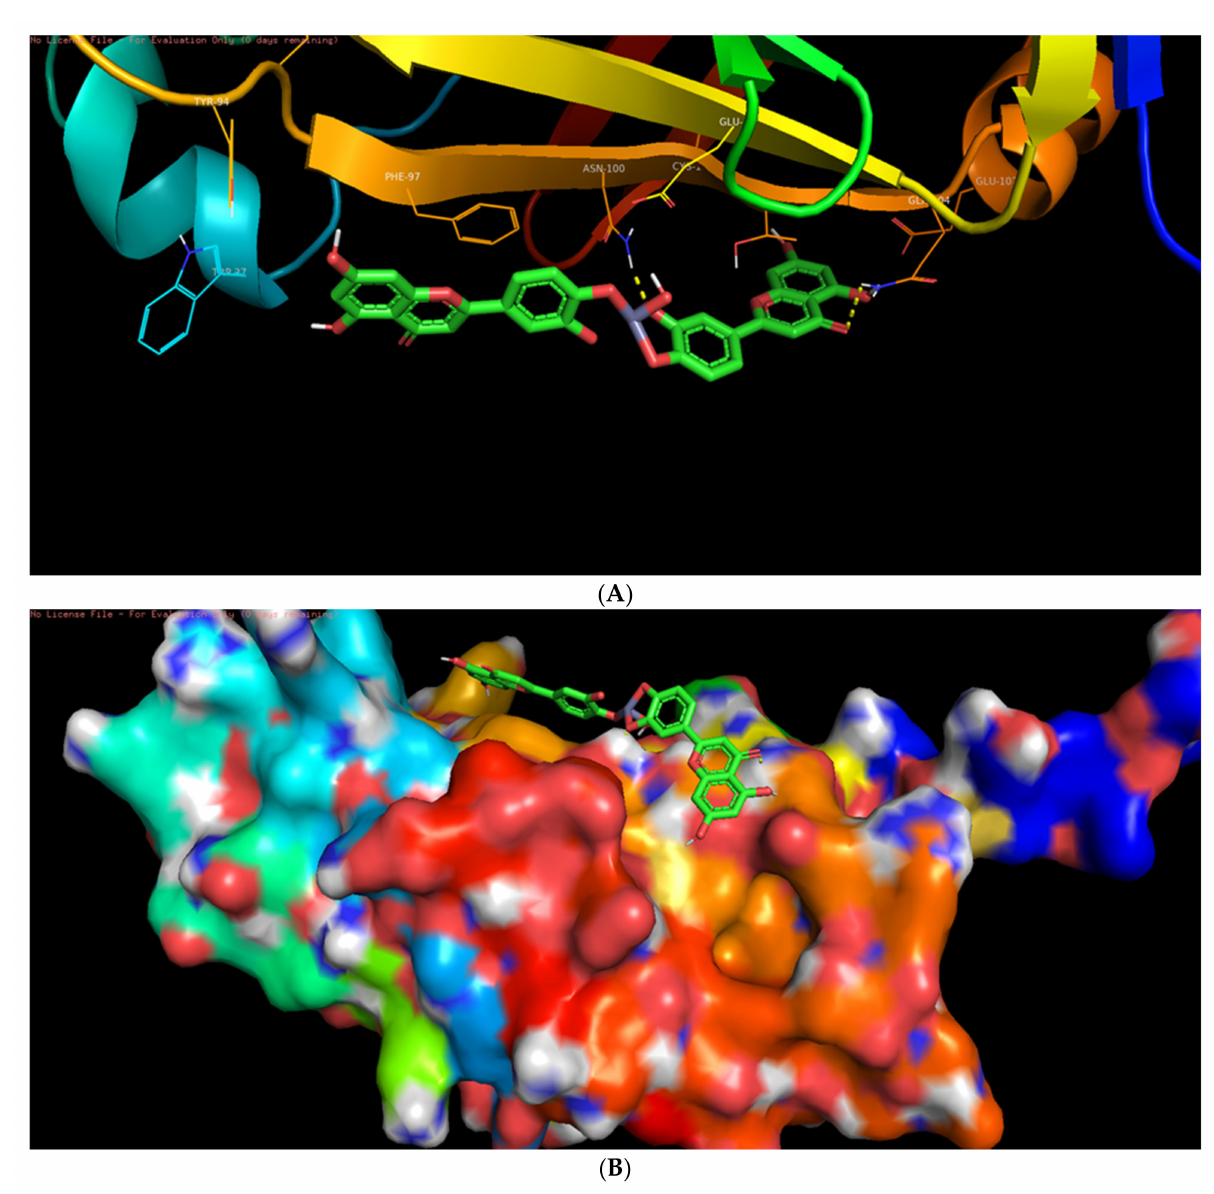
Figure 13. ( A ) The bonded and non-bonded interactions of L-ZnONPs with the cancer protein 2FK9. ( B ) The best-docked pose of L-ZnONPs bound to the hydrophobic preset of the 2FK9